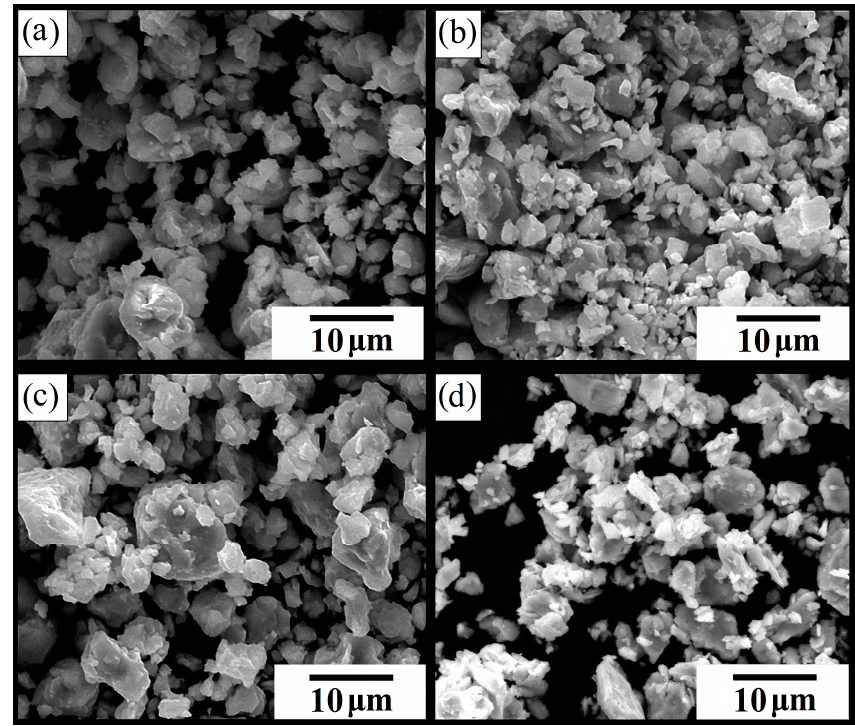
Figure 1. Scanning electron microscopy (SEM) images of the local microstructures of the following samples: ( a ) (Fe 0.65 Co 0.35 ) 0.95 (La 2 O 3 ) 0.05 , ( b ) (Fe 0.65 Co 0.35 ) 0.95 (Nd 2 O 3 ) 0.05 , ( c ) (Fe 0.65 Co 0.35 ) 0.95 (Sm 2 O 3 ) 0.05 , and ( d ) Fe 0.65 Co 0.35 (3